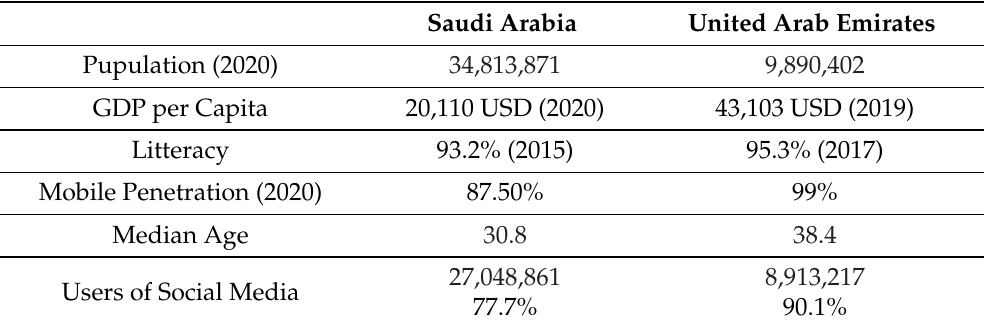
Table 2. A comparison of financial customers between Saudi Arabia and the United Arab Emirates (source: World